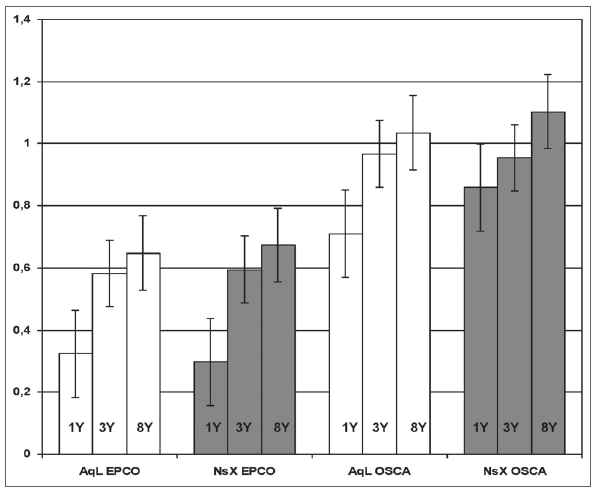
Fig. 2. Comparison of mean total EPCO 2000 indexes and OSCA scores after AqL and NSX phacoemulsification 1, 3, and 8 years after cataract surgery, with error bars. The differ- ence in EPCO 2000 outcomes was not significant. There was a significant difference in OSCA scores 1 year and 8 years postop- eratively and nonsignificant difference 3 years postoperatively. White bars = AquaLase group; gray bars = NeoSoniX